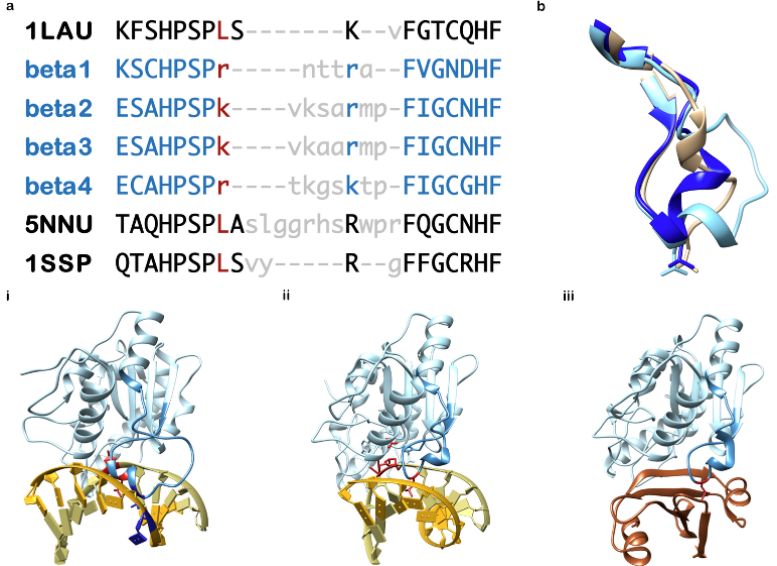
Figure 5. Sequence and structure alignment of the herpesvirus adapted motif central to Ung catalysis. ( a ) Multiple sequence alignment of the Ung minor groove DNA intercalation loop motif, generated via structural superposition of protein chains: UNG2 (Human), UL2 (HHV-1), and ORF46 / HHV8GK18_gp50 (HHV-8), using the program Chimera: PDB accession codes are used (UNG2 = 1SSP; UL2 = 1LAU; ORF46 = 5NNU, chain A). Ung sequences for which there is currently no deposited molecular structure (i.e., β -herpesviruses) are indicated in blue font (beta 1 = HHV-5; beta 2 = HHV-6A; beta 3 = HHV-6B; beta 4 = HHV-7). Residue positions lacking structural equivalence are shown in lower case with gross differences in grey font. The Ung catalytic leucine residue is in dark red font as are (in lower case) positionally equivalent betaherpesvirus residues. ( b ) Cartoon structure excerpts of the aligned region only, overlaid (from 1LAU, 1SSP and 5NNU). ( c ) The sequence aligned is displayed as a darker shaded region of the entire Ung molecule in its biological contexts: ( i ) 5NNU: ORF46 (HHV-8) Ung [chain A] in complex with dsDNA [chains S and T] ( ii ) 1SSP: UNG2 (Human) [chain E] in complex with dsDNA [chains A and B], ( iii ) 1UDH: UNG2 [chain E] in complex with Ugi [chain I], a protein mimic of DNA that specifically targets Ung. Highlighted in dark red is the Ung catalytic leucine (i,ii,iii) and catalysed DNA residue (i,ii); highlighted in dark blue (i) and unique to gammaherpesvirus Ung is a key residue of an exaptation that precisely deforms DNA (also highlighted dark blue) as a possible signal essential to viral DNA replication assembly in gammaherpesviruses: This novel exaptation, shown for 5NNU (HHV-8 Ung), is conserved in HHV-4 (deposited as pdb structure 2J8X – not shown).